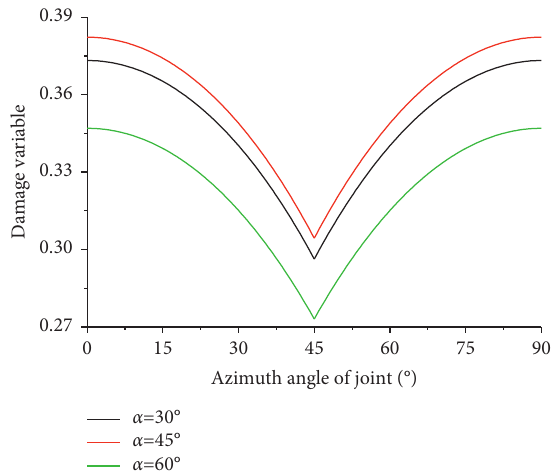
Figure 4: The change in the damage variable of a coal body containing a joint with azimuth angle of the